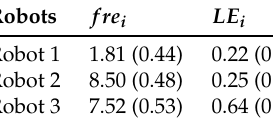
Table 3. Mean (standard deviation) results in communication frequency (%) and localization error (m) based on 30 runs for Case 1.